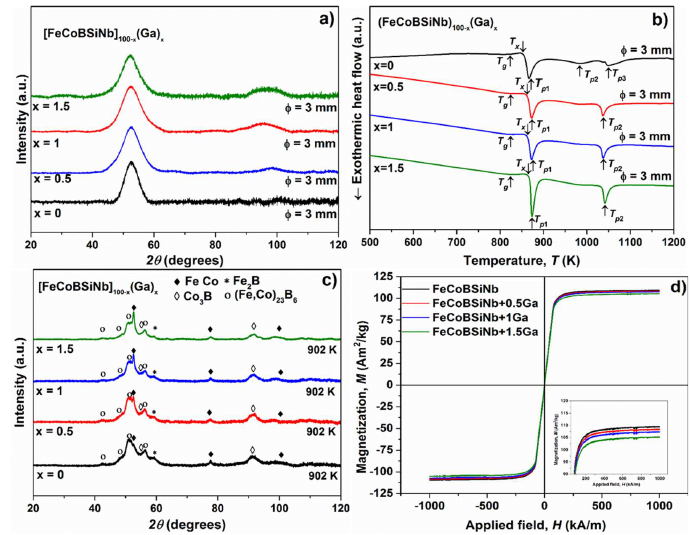
Figure 1. ( a ) XRD patterns and ( b ) DSC traces (heating rate 20 K / min) of as-cast [FeCoBSiNb] 100 − x (Ga) x (x = 0, 0.5, 1 and 1.5) glassy samples with maximum achievable diameter for each composition; ( c ) XRD patterns of [FeCoBSiNb] 100 − x (Ga) x (x = 0, 0.5, 1 and 1.5) samples heated up to the end of the first crystallization event; ( d ) Hysteresis loops for 1 mm diameter as-cast [FeCoBSiNb] 100 − x (Ga) x (x = 0, 0.5, 1 and 1.5) glassy samples. The inset shows the behavior of the Ga-doped samples close to the saturation region, i.e., between 80 and 100 Am 2 /